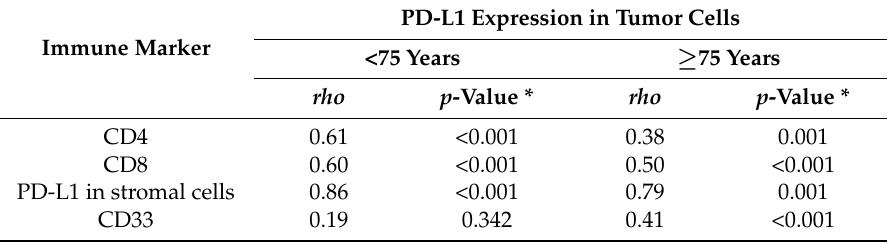
Table 1. Correlation between the PD-L1 expression in tumor cells and the TAICs density by mm 2 according to the age of patients with LADC.